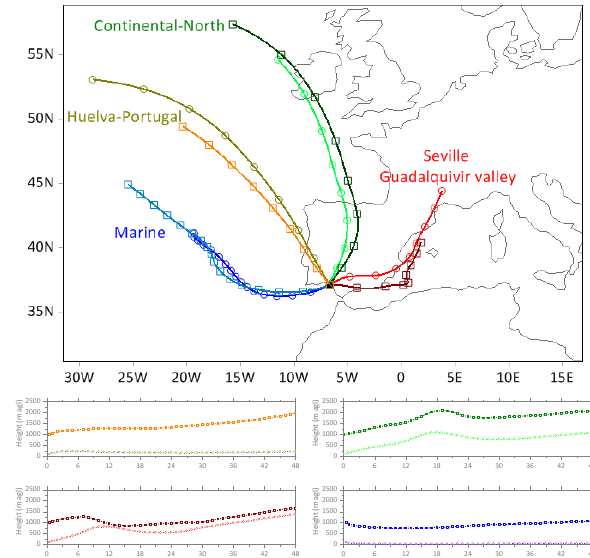
Fig. 3. Back trajectories cluster means (horizontal and vertical vari- ation) of 48h computed for 100 and 1000m arrival height at El Arenosillo representative of the flows from the Huelva–Portugal, continental–north, Seville–Guadalquivir valley and marine